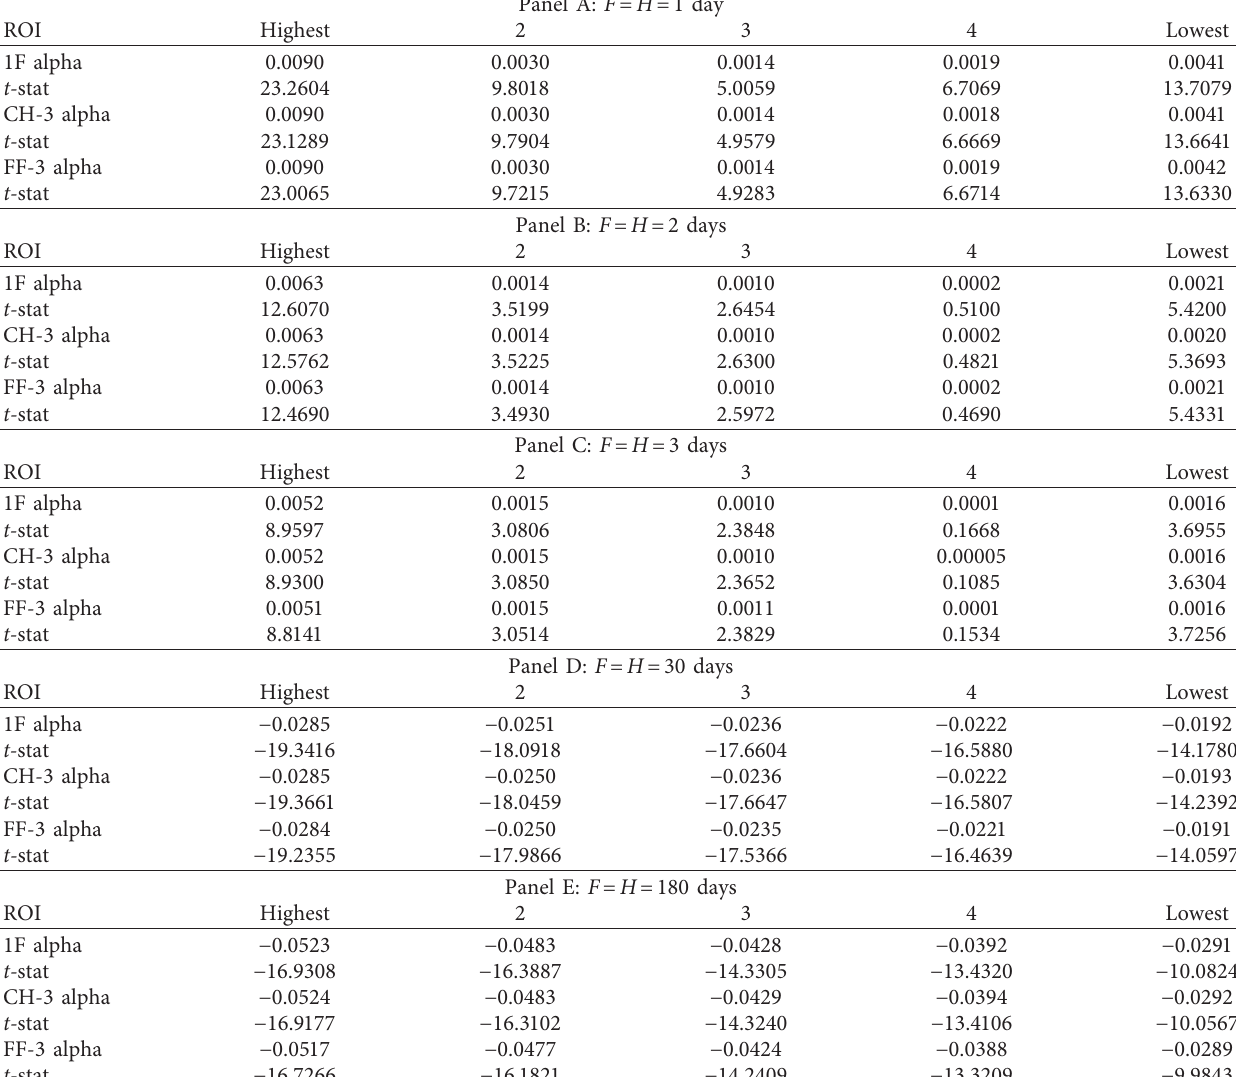
Table 4: The effect of the daily relative order imbalance after risk adjustments of the A-share